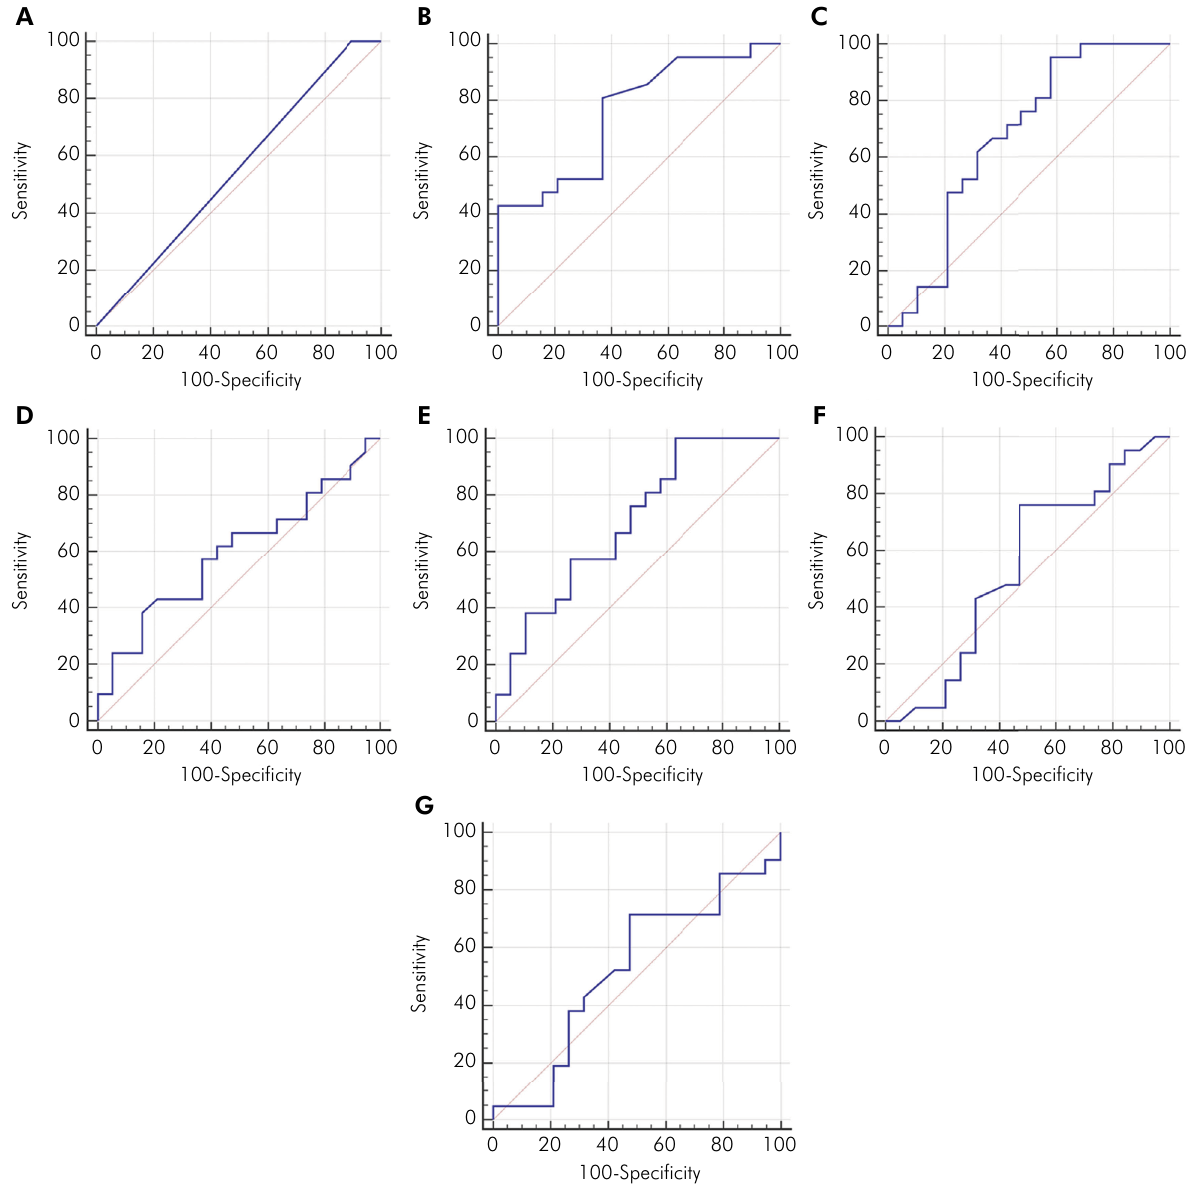
Figure 5. Graphs representing the receiver operator characteristic (ROC) of the mandibular cortical index (A) , mandibular cortical width (B) , fractal dimension of the mandible angle (C) , region anterior to the mental foramen (D) , total trabecular bone (E) , cortical bone with hyoid bone (F) , and cortical bone without hyoid bone (G)